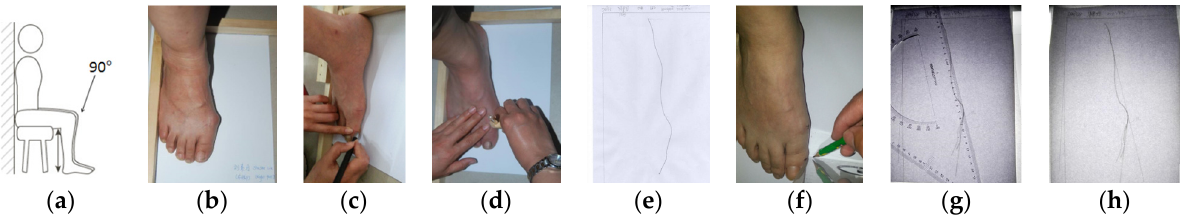
Figure 3. Standard Operating Procedure ( a – h ) of measuring the HVA